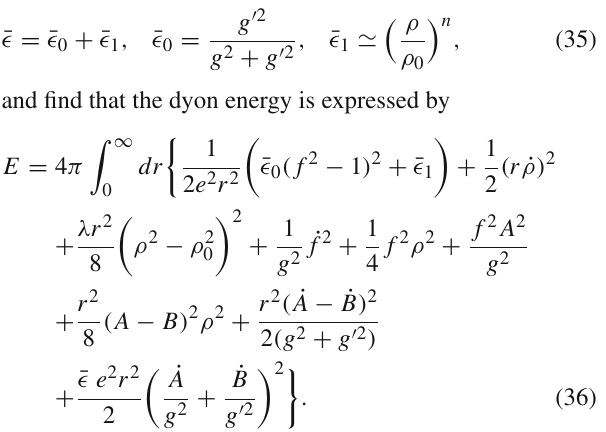
solution (with n > 2). The monopole solution with n = 6 is shown in Fig. 4. We could generalize the monopole solution to dyon by solving (33). The solution with n = 6 is shown in Fig. 5. Remarkably the solutions look almost identical to the solutions shown in Figs. 1 and 2. But the difference is that here ¯ (cid:14) has a non-vanishing value ¯ (cid:14) 0 at the origin. Of course, the energy depends on n , and we can plot the monopole energy in terms of n . This is shown in Fig. 6 in red dots. For n = 6 the energy is given by 7.96 TeV. For comparison we plot the monopole energy regularized by (cid:14) (by the hypercharge renormalization) in blue dots. Notice that the energy approaches to the asymptotic value roughly given by 3.75 TeV shown in black dotted